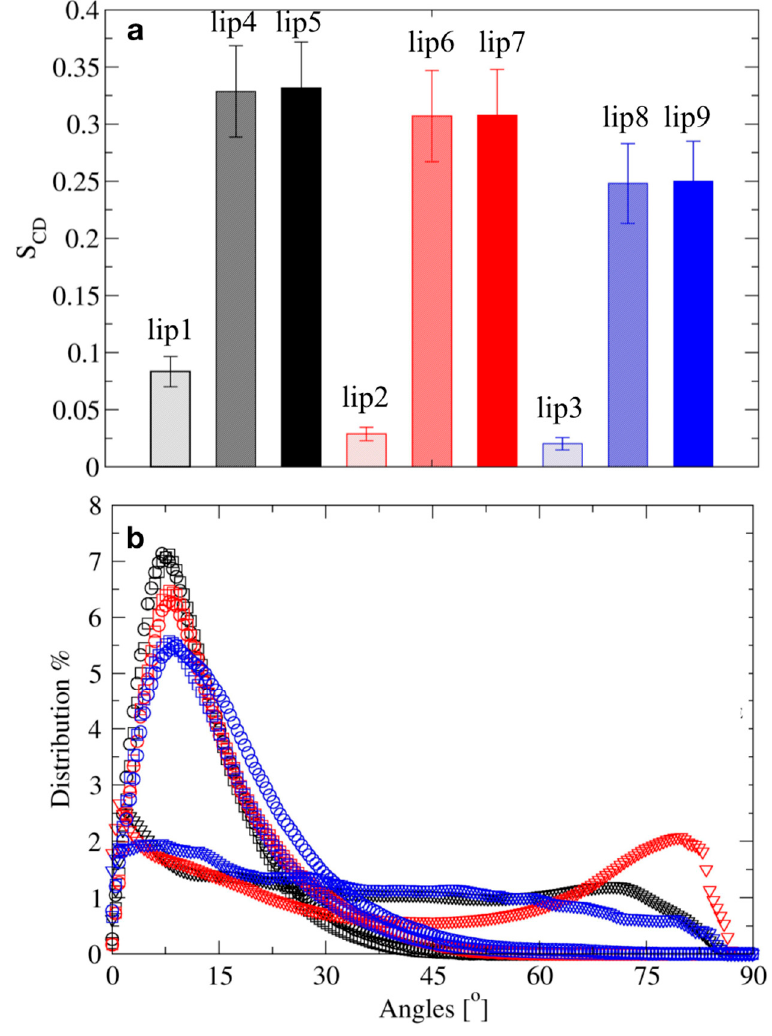
Figure 5. The effect of the equilibration protocols on the dynamical properties of the lipid-A membranes in the presence of Al 3+ counterions without additional salts (black), 150 mM of AlCl 3 (red), and 150 mM of NaCl (blue). Equilibration with NPT-only (triangles) and stepwise-thermalization NVT/NPT using the reaction field (squares) or PME (circles) approximations. ( a ) Average deuterium order parameters S CD for acyl chains. ( b ) Distribution of the time-averaged surface curvature angle, S C . Averages were calculated over the last 100 ns of simulation.